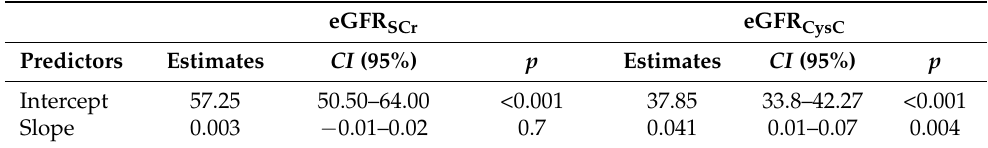
Table 3. The output of the mixed-effect model results.